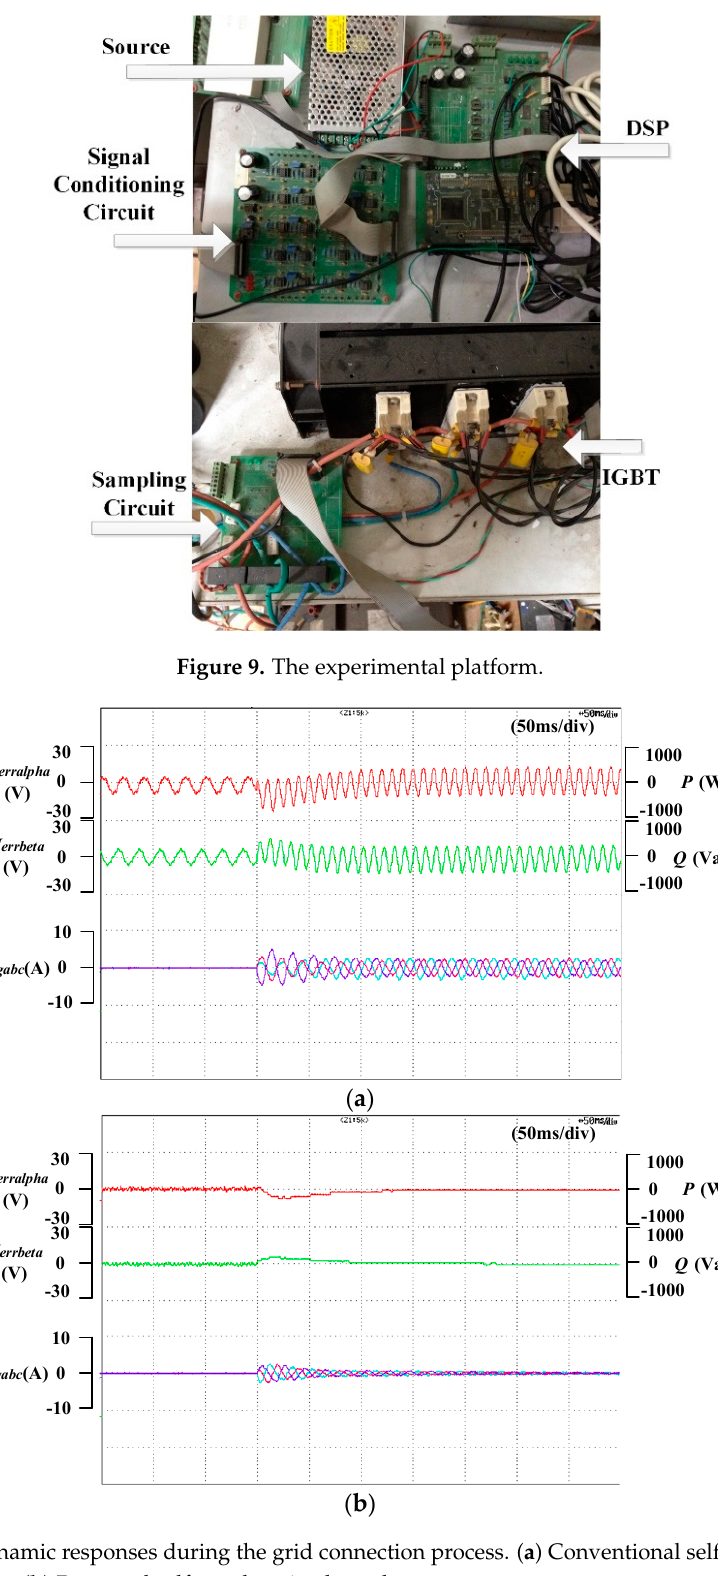
Figure 10. Dynamic responses during the grid connection process. ( a ) Conventional self-synchronized synchronverter. ( b ) Proposed self-synchronized synchronverter. Before the grid connection, the voltage errors between the grid and converter voltages are shown in 𝛼 and 𝛽 axes separately. And the voltage errors are changed to active and reactive